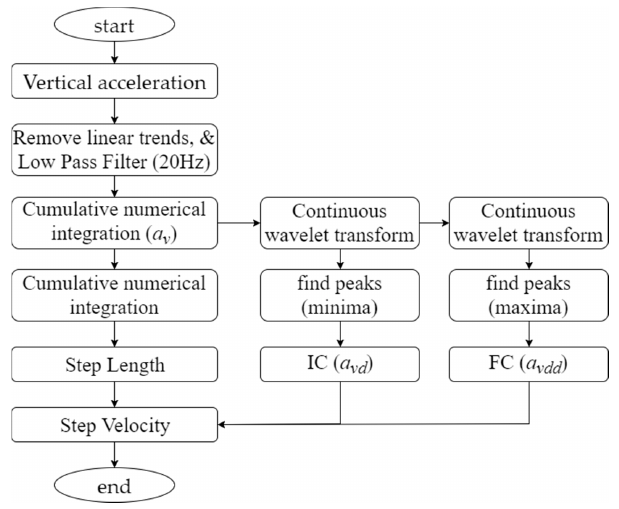
Figure 3. Procedure for processing accelerometer signals for gait detection.